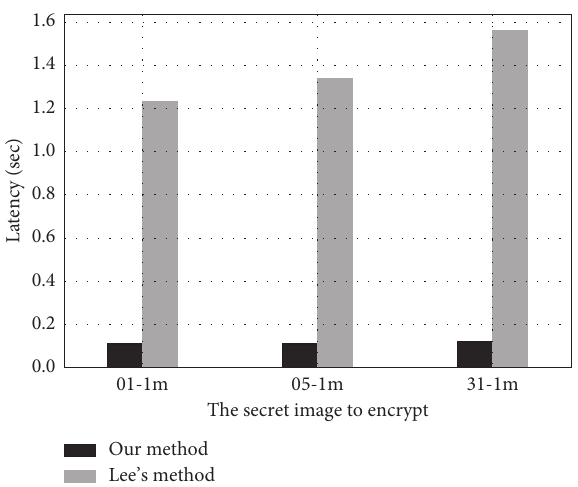
Figure 2: The encryption time comparison between our and Lee’s [24] Table 3: The performance of our networks on IMM and LFW datasets for normal and recovery images, respectively.